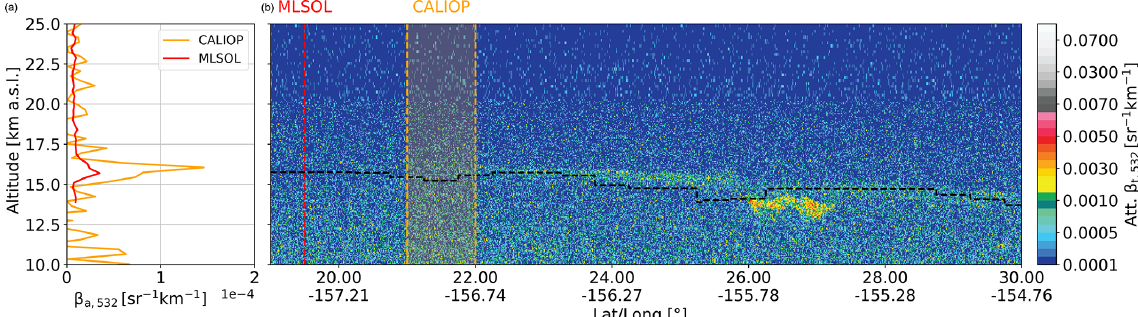
Figure 4. Overview of the CALIOP attenuated backscatter measurements during the 31 August 2019 overpass in the Hawaii area (a) . The 1 September 2019 MLSOL aerosol backscatter observations ( b , red) are presented together with the aerosol backscatter retrieval from the CALIOP ( a , orange) for the southern part of the plume (shaded orange).